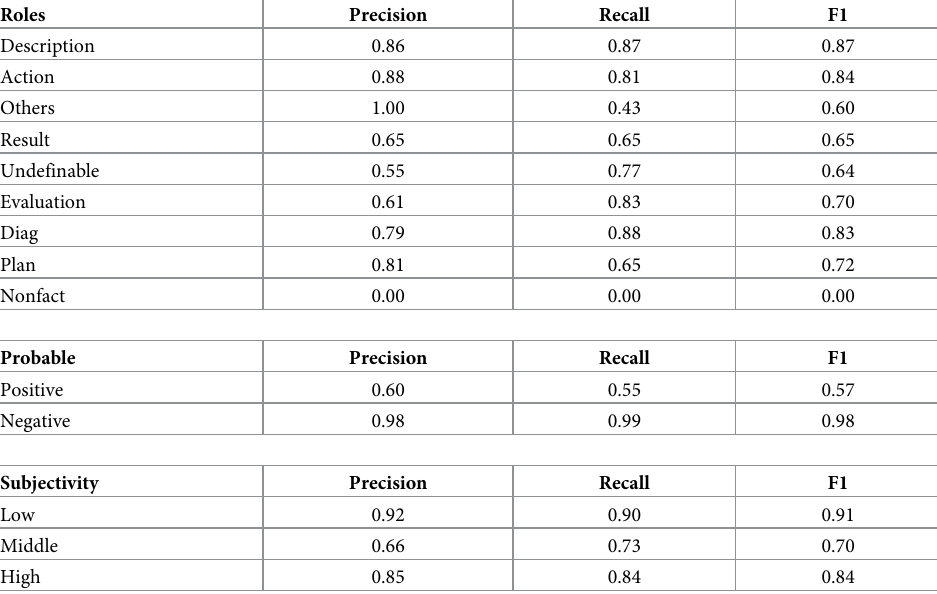
Table 4. Results of automatic labeling using dummy record. The hyperparameters of λ 0.25, and 0.25 for subjectivity; 0.25, 0.75, and 0 for clinical role; and 0.33, 0.33, and 0.33 for probable label. Roles Precision Recall